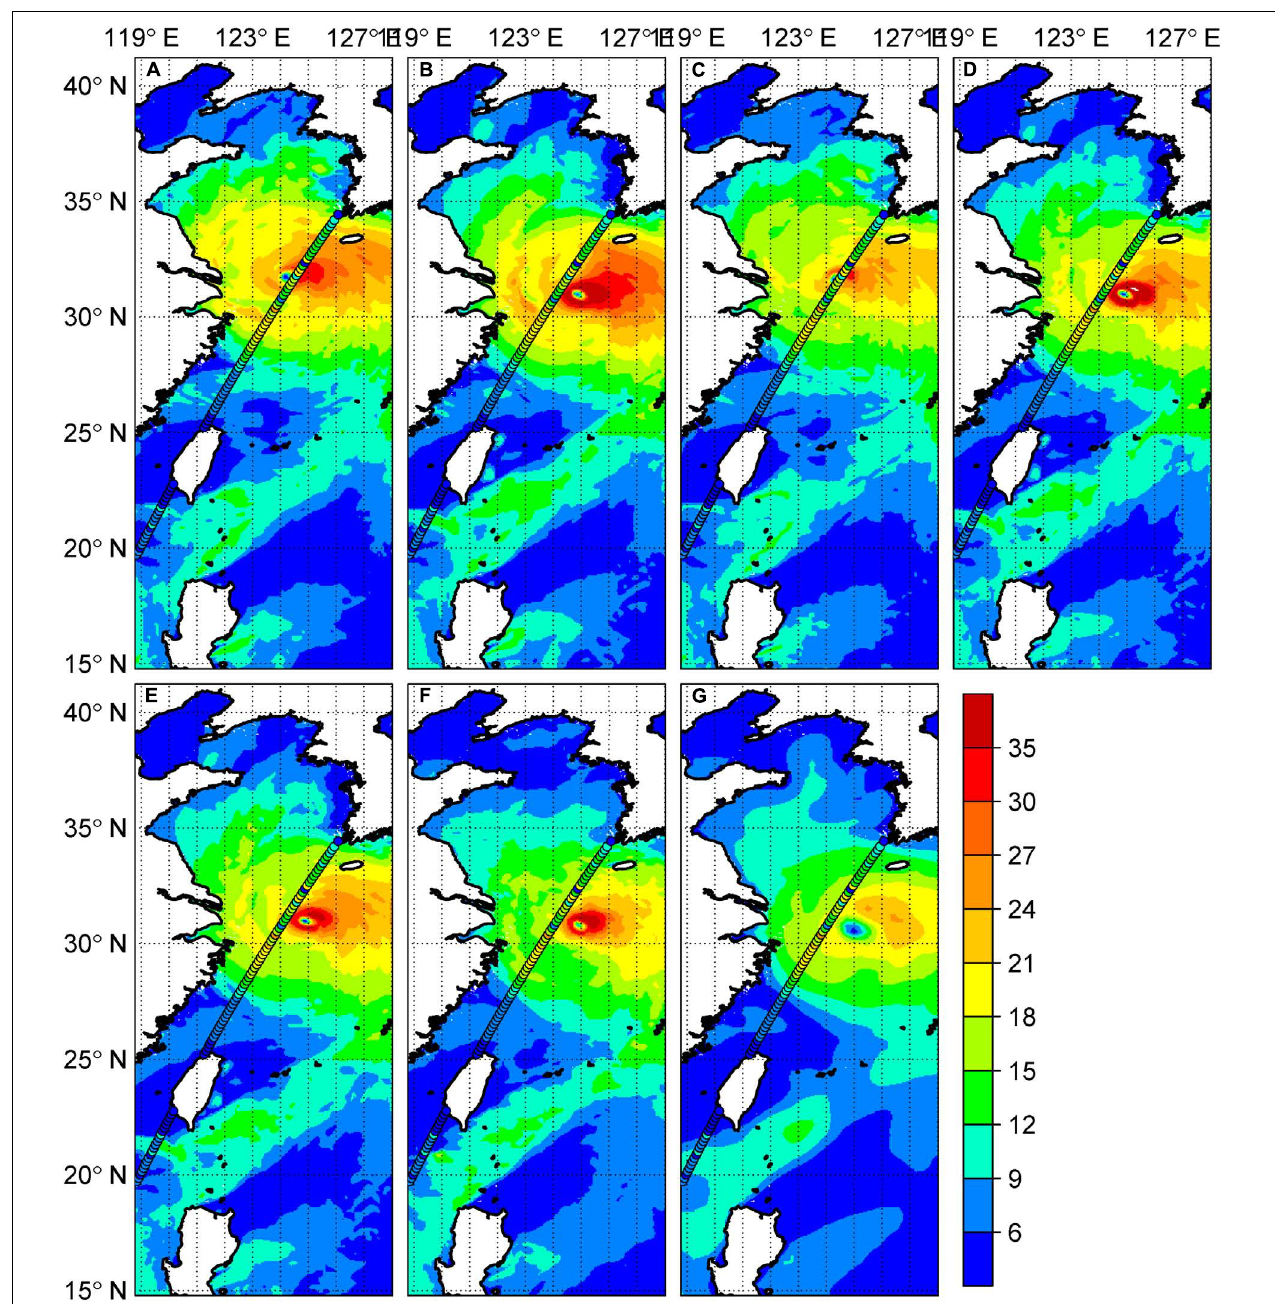
FIGURE 4 | Snapshots of the modeled surface wind speed (m/s) at 10:00 UTC 6 September 2019 for (A) 1w_wind, (B) 1w_wind_SN, (C) 2w_new, (D) 2w_new_SN, (E) 2w_old_SN, (F) ECMWF, and (G) ERA5. The overlapping points represent the Jason2 satellite